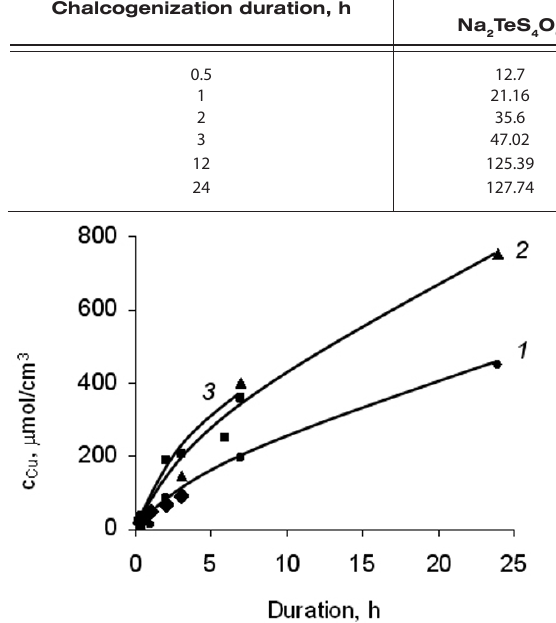
Sheet resistance of Cu layers on PA